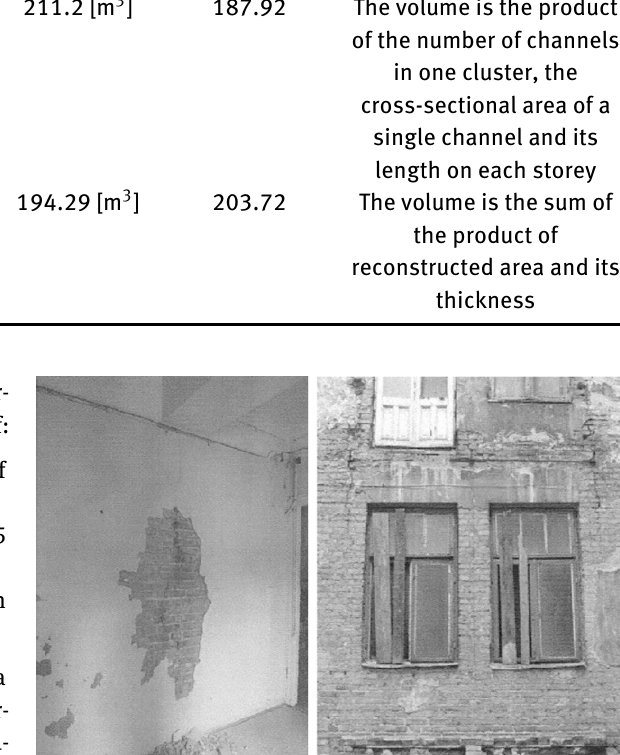
The excess Method of quantity survey over bill of quantities [%]